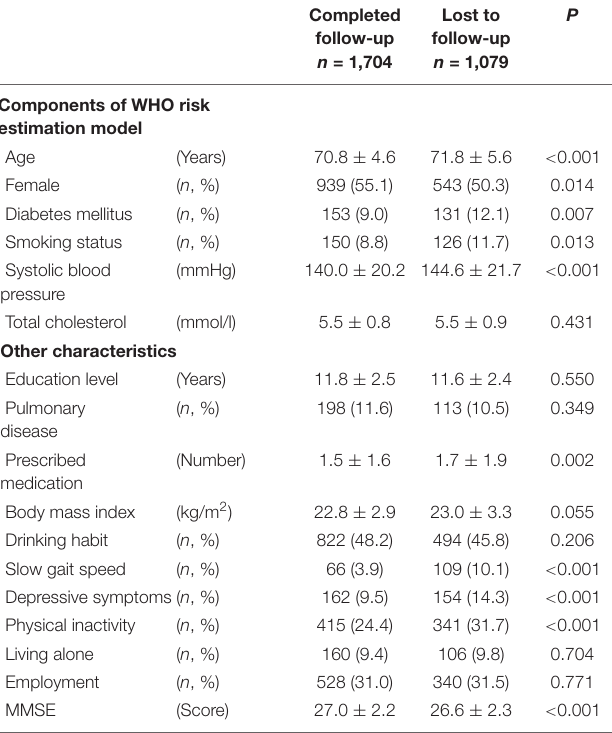
TABLE 1 | Comparison of baseline characteristics between participants who completed follow-up assessment and participants who were lost to follow-up